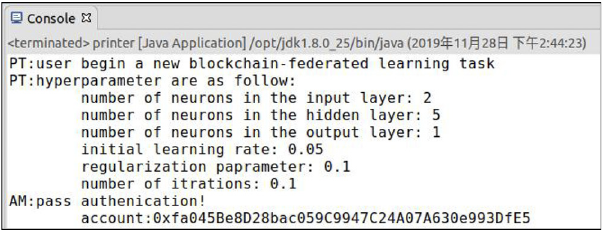
Figure 8. Smart agent